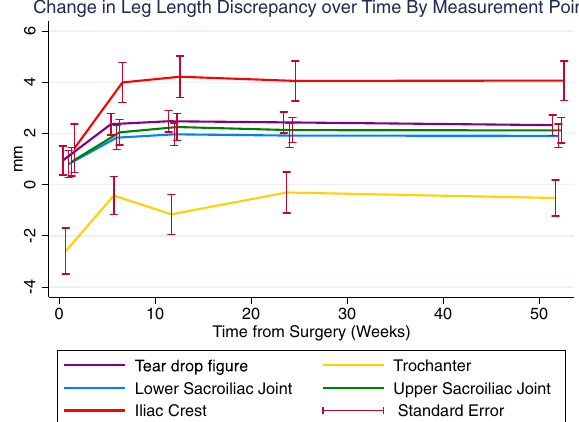
Figure 2. Leg length differences measured at five anatomical landmarks at 1, 6, 12, 24 and 52 weeks after THA. Measures at the tear drop figure and the upper and lower sacroiliac joints were similar, whereas LLD measures at the iliac crest revealed significantly larger values. Interestingly, an LLD increase occurred from week 1 to week 6 at all measure points. This can be referred to relieving postures with unstraightened operated legs at week 1. As reference, measures at the trochanter feature the same progression.